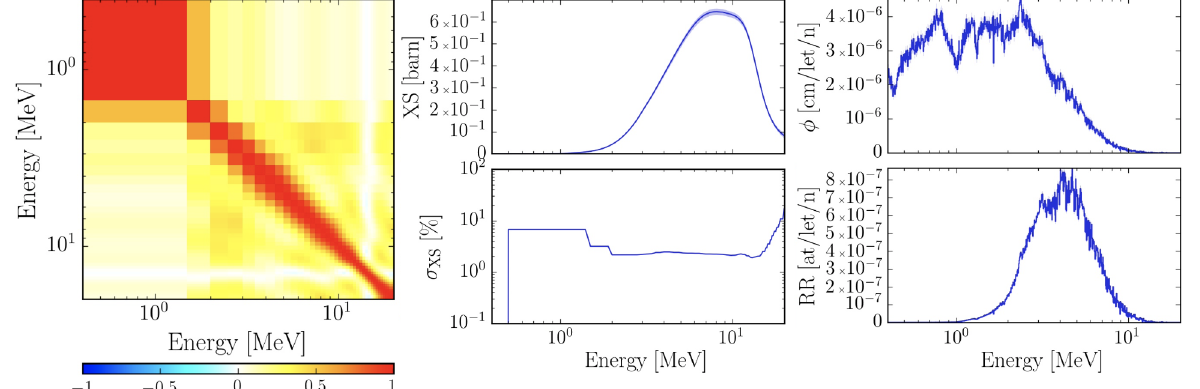
Figure 6: IRDFF covariance (left), cross-section (top-middle) and cross section uncertainties (bottom-middle) used for the uncertainty propagation with the neutron flux (top-right) and reaction rate (bottom-right) spectrum in the nickel